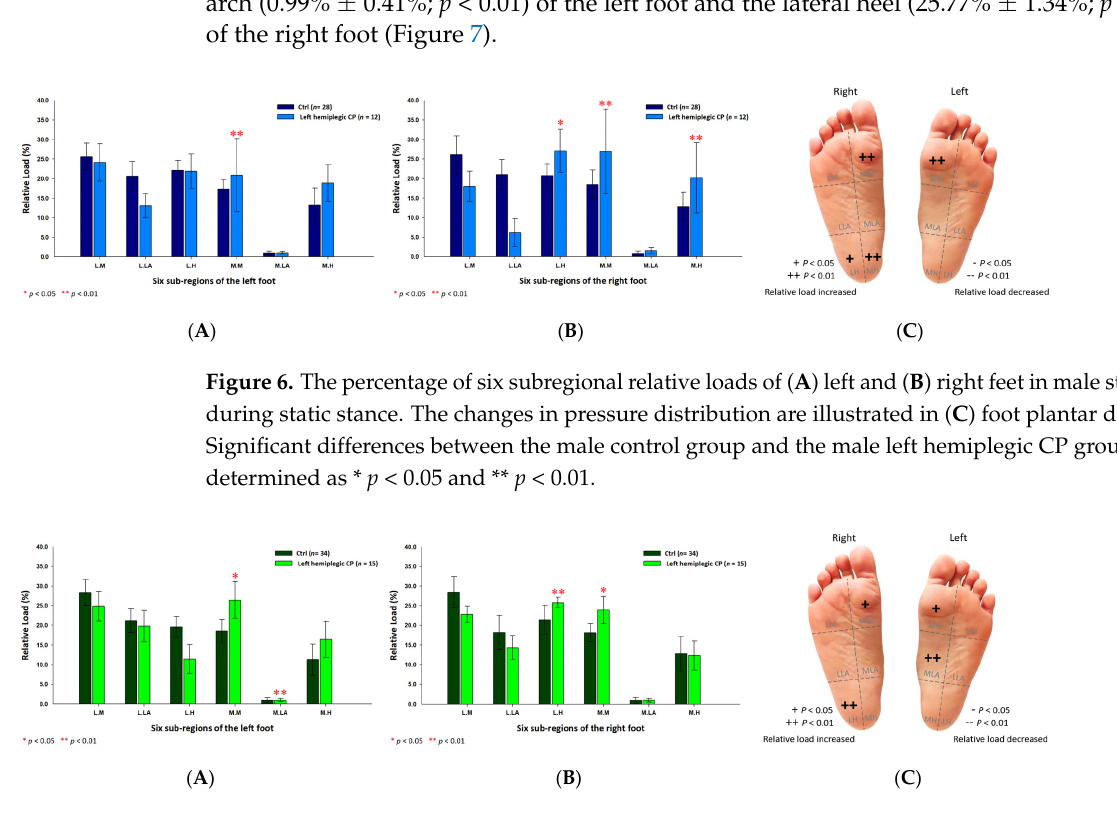
26.42% ± 4.67%; right foot: 23.85% ± 3.43%; p < 0.05) of both feet, the medial longitudinal arch (0.99% ± 0.41%; p < 0.01) of the left foot and the lateral heel (25.77% ± 1.34%; p < 0.01) of the right foot (Figure 7).